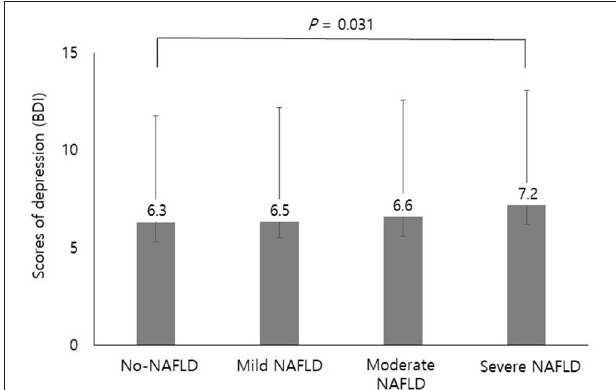
FIGURE 2 | Scores of depression according to the stage of steatosis. The BDI score was significantly higher in the severe NAFLD group compared to the no-NAFLD group (7.2 ± 5.9 vs. 6.3 ± 5.5). Differences in depression levels among the stages of steatosis were analyzed using one-way ANOVA with